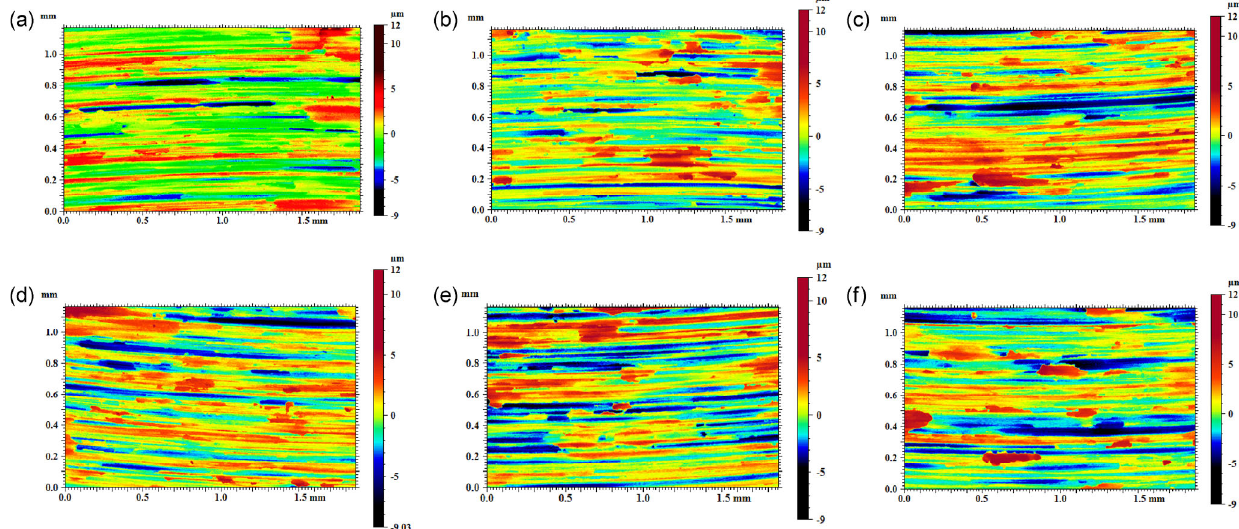
Fig. 7 Surface maps of pin surfaces after short duration tests: (a) S1, (b) S2, (c) S3, (d) S4, (e) S5, and (f)